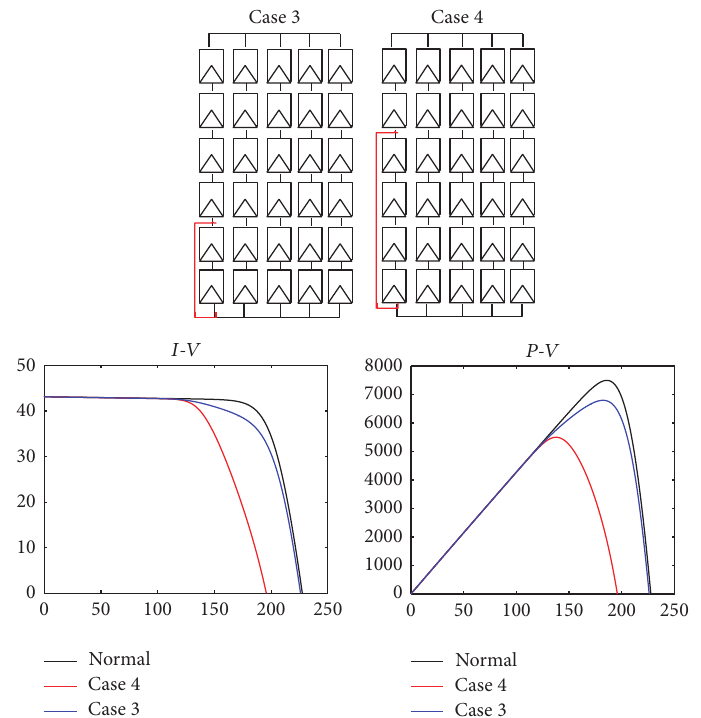
Figure 5: The PV array configuration for line-to-line